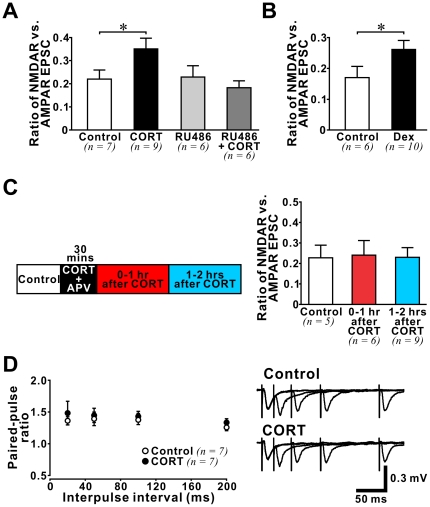
Characteristics of CORT-induced enhancement of NMDAR-mediated synaptic function in the adult hippocampus.(A) Histogram shows the NMDAR/AMPAR ratio recorded from slices exposed to one of the following treatments: control (white), CORT (black (100 nM)), GR antagonist RU486 (light grey (500 nM)), and RU486 + CORT (dark grey). Note that only CORT-treated slices exhibited an increase in NMDAR/AMPAR ratio. * p<0.05: post-hoc Fisher's test after ANOVA. (B) Increase in NMDAR/AMPAR ratio was induced by a GR agonist dexamethasone (Dex (200 nM)). * p<0.05: student's t-test. (C) Left: A schematic time line illustrates the time windows for drug treatment (CORT (100 nM) + APV (50 µM)) and recording. Evoked EPSCs were recorded from CA1 pyramidal neurons in control slices and drug-treated slices in two time windows: 0–1 hour and 1–2 hours after CORT treatment. Changes in NMDAR/AMPAR ratio at these time windows were summarized in a histogram (right). Note that CORT did not alter NMDAR/AMPAR ratio when NMDAR was blocked by APV during CORT treatment. (D) Plots on the left show no difference between paired-pulse ratios recorded from control slices (white circles) and slices during CORT treatment (black circles). Average traces on the right are representative examples.